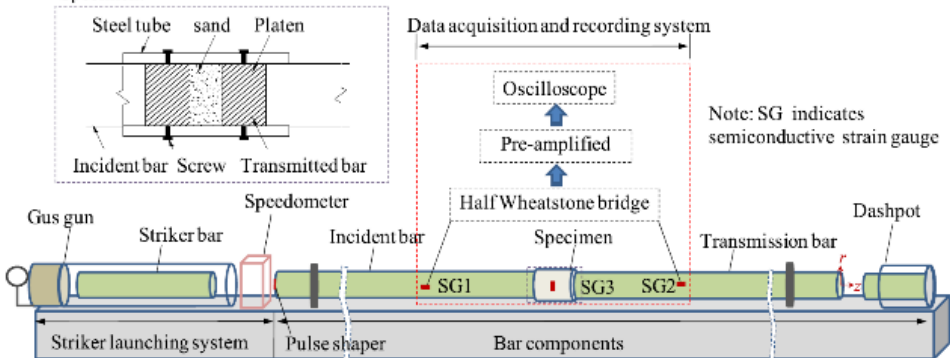
Figure 12. Schematic view of SHPB test stand (reprinted from Ref. [77]).